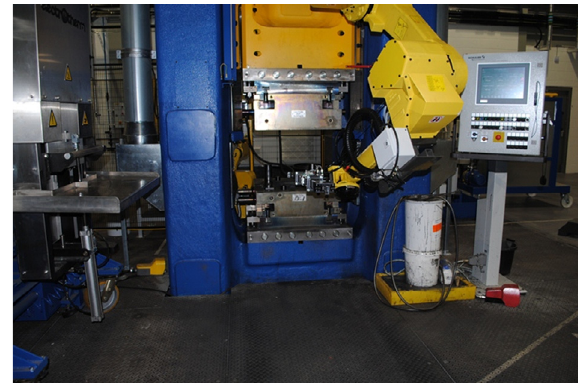
Figure 16. Fanuc M710 robot mounted inverted on